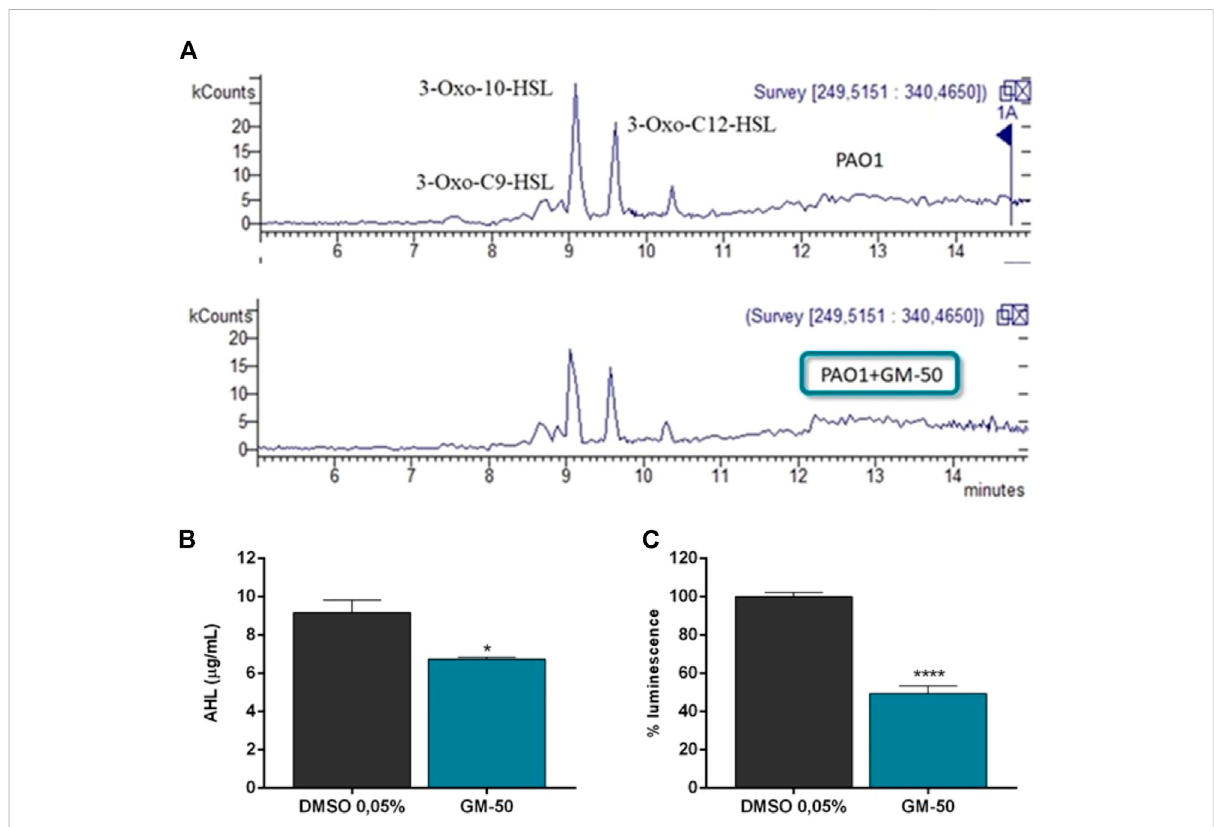
FIGURE 3 Effect of GM-50 on AHL production. PAO1 (10 6 CFU/ml) were cultured in LB with GM-50 (100 µM) or DMSO 0.05% (vehicle) for 24 h at 37 ° C. After incubation, supernatants were used to quantify AHL production adopting LC-MS technology using both reverse phase chromatography and luminescence assay. (A) LC-MS chromatogram of collected supernatants. C6HSL ( m/z 200), 3-Oxo-C9-HSL ( m/z 256), N-decanoyl-homoserine lactone (m/z 256), 3-Oxo-10-HSL N-dodecanoyl-homoserine lactone ( m/z 270), 3-oxo-C12-HSL ( m/z 284), 3-Oxo-C12-HSL isomer 1 and 2 ( m/z 298) were detected. (B) Total quanti fi cation of AHL molecules is reported as µg/mL. (C) Supernatants were added to Vibrio harveyi BB120. Luminescence was quanti fi edafter 24 h. Results obtained with PAO1 cultured with DMSO were arbitrarily assigned100% AHL production. * p < 0.05, ** p < 0.01 vs . PAO1 with DMSO